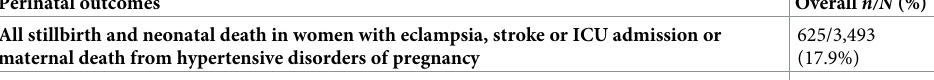
Table 3. Perinatal outcomes for mothers with antenatal eclampsia, stroke, or hypertensive disorders of pregnancy causing death or intensive care unit (ICU) admission. Perinatal